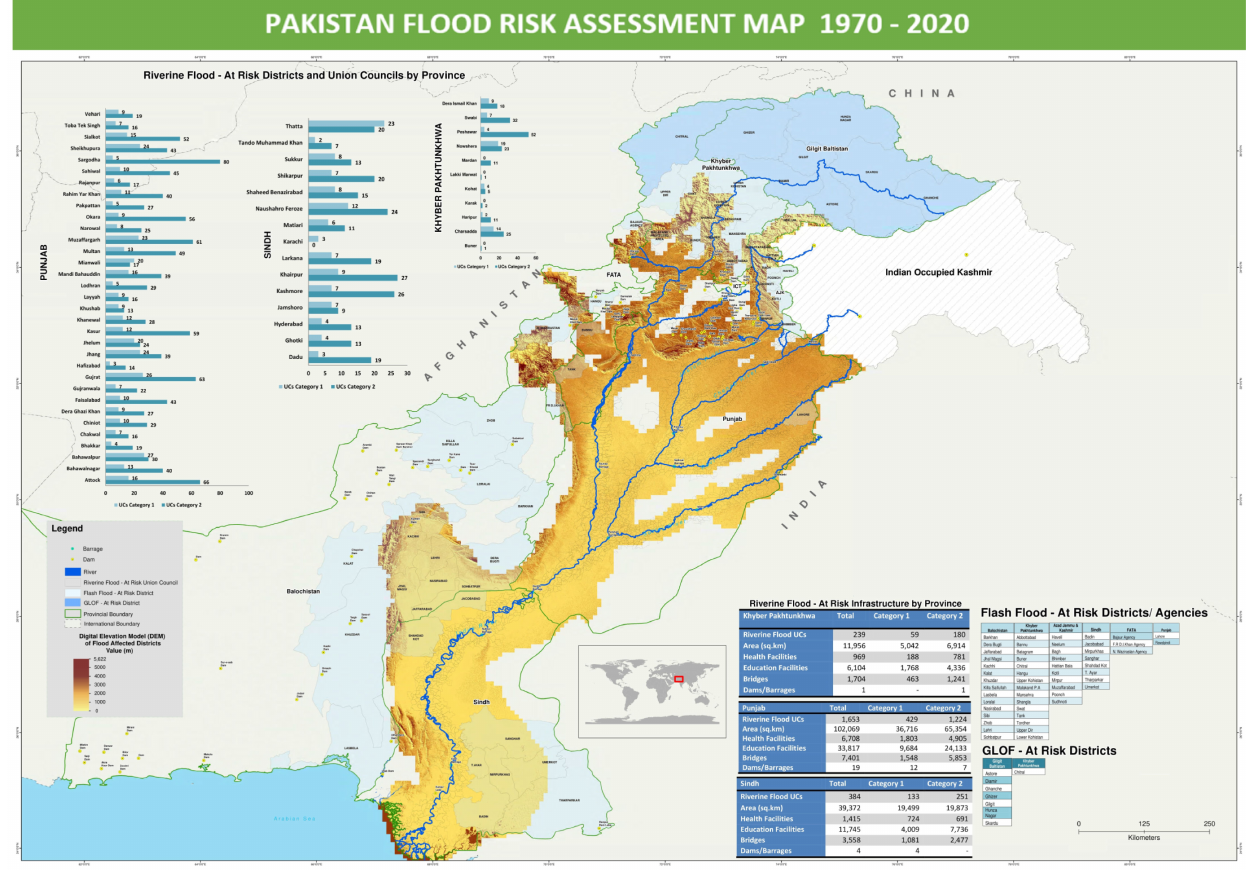
Figure 15. Flood Hazard Risk Assessment of Pakistan at union council and district level and damages to infrastructures by